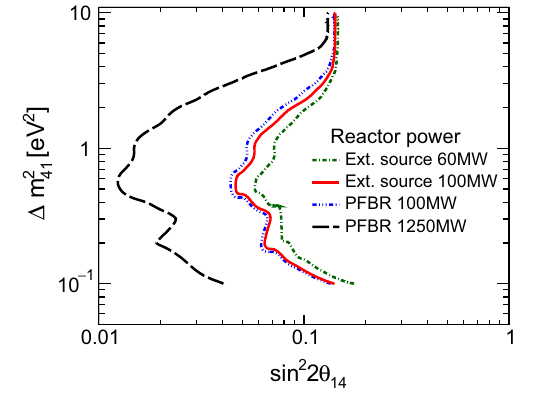
Fig. 7 The 90% C.L. exclusion limits in the Δ m 2 where sin 2 2 θ 14 = 4 U 2 data at different reactor thermal power